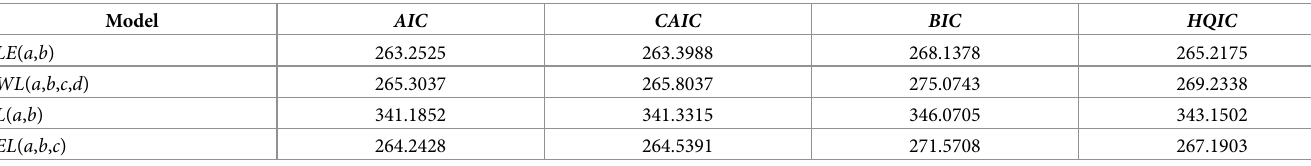
Table 4. Goodness of fit Criteria: AIC, CAIC, BIC, HQIC for data set 2.